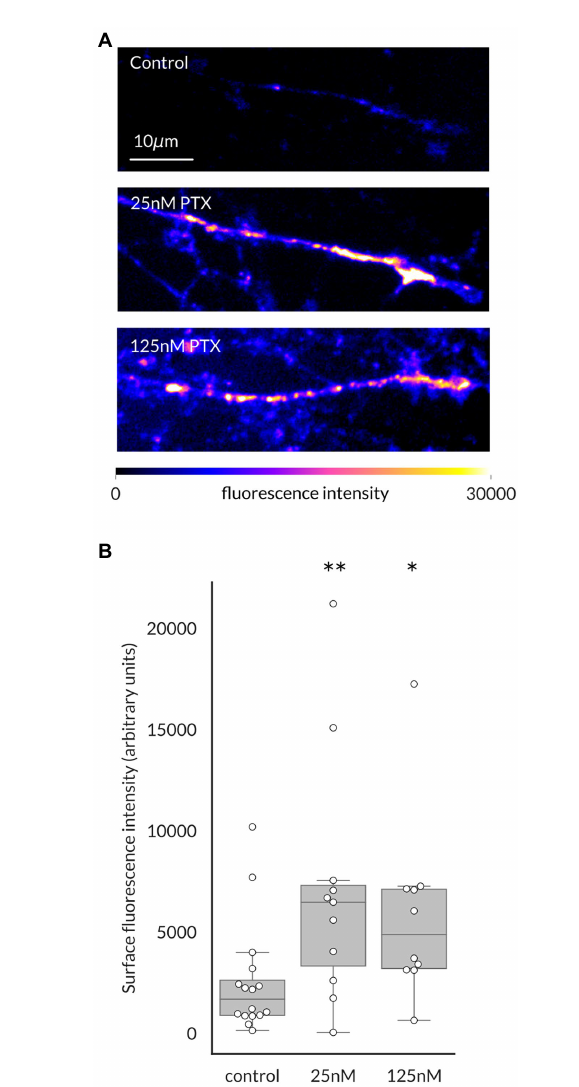
FIGURE 2 Effects of paclitaxel on content and velocity of vesicles carrying Na V 1.8 channels to distal axons. (A) Violin plots and box plots showing treatment of DRG neurons for 24 h with 25 nM or 125 nM PTX enhances the average velocity of Na V 1.8-containing particles ( ** p = 6.3 × 10 − 8 and * p = 4.5 × 10 − 6 by Mann–Whitney U test with Bonferroni correction, respectively). Each point indicates the average velocity of a particle over the 40s imaging epoch; at least 3 independent DRG cultures were assayed for each condition. (B) Median vesicular fluorescence intensity was significantly increased by PTX treatment of 25 nM ( * p = 0.02 by corrected Mann–Whitney U test).